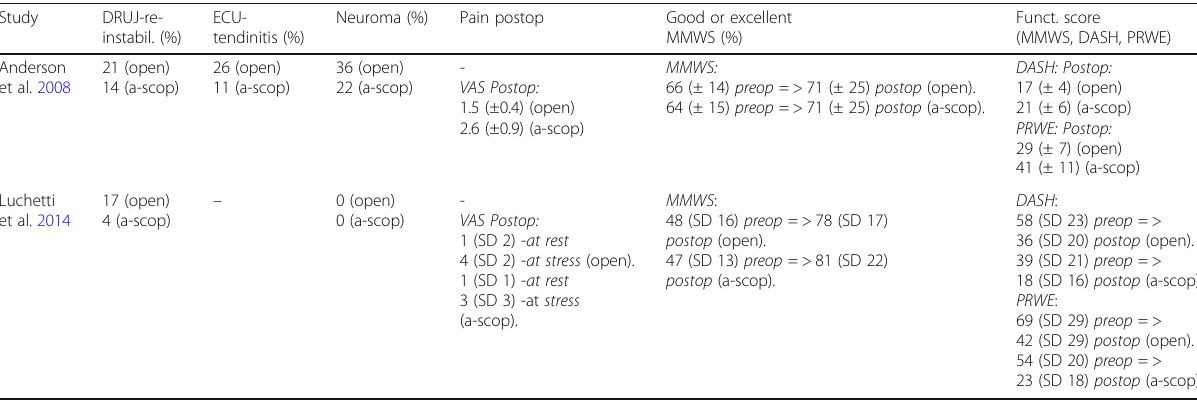
Table 2 Outcome measures (Open = open repair of TFCC, a-scop = arthroscopic repair of the TFCC, DRUJ = distal radio-ulnar joint, ECU = extensor carpi ulnaris, VAS = Visual Analog Scale, MMWS = Modified Mayo Wrist Score, DASH = Disability of the Shoulder, Arm and Hand, PRWE = Patient-rated Wrist